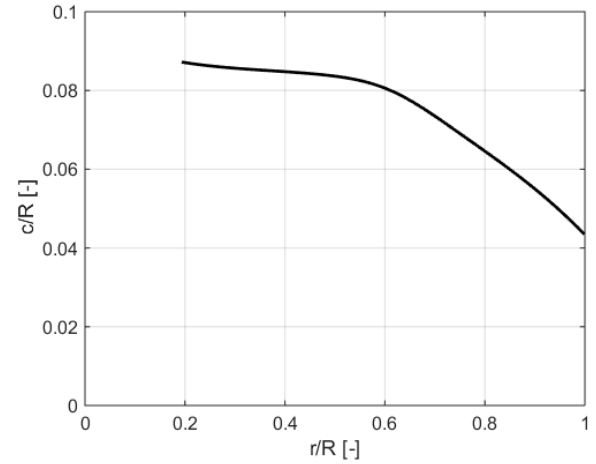
Figure 3. Propeller blade chord distribution.